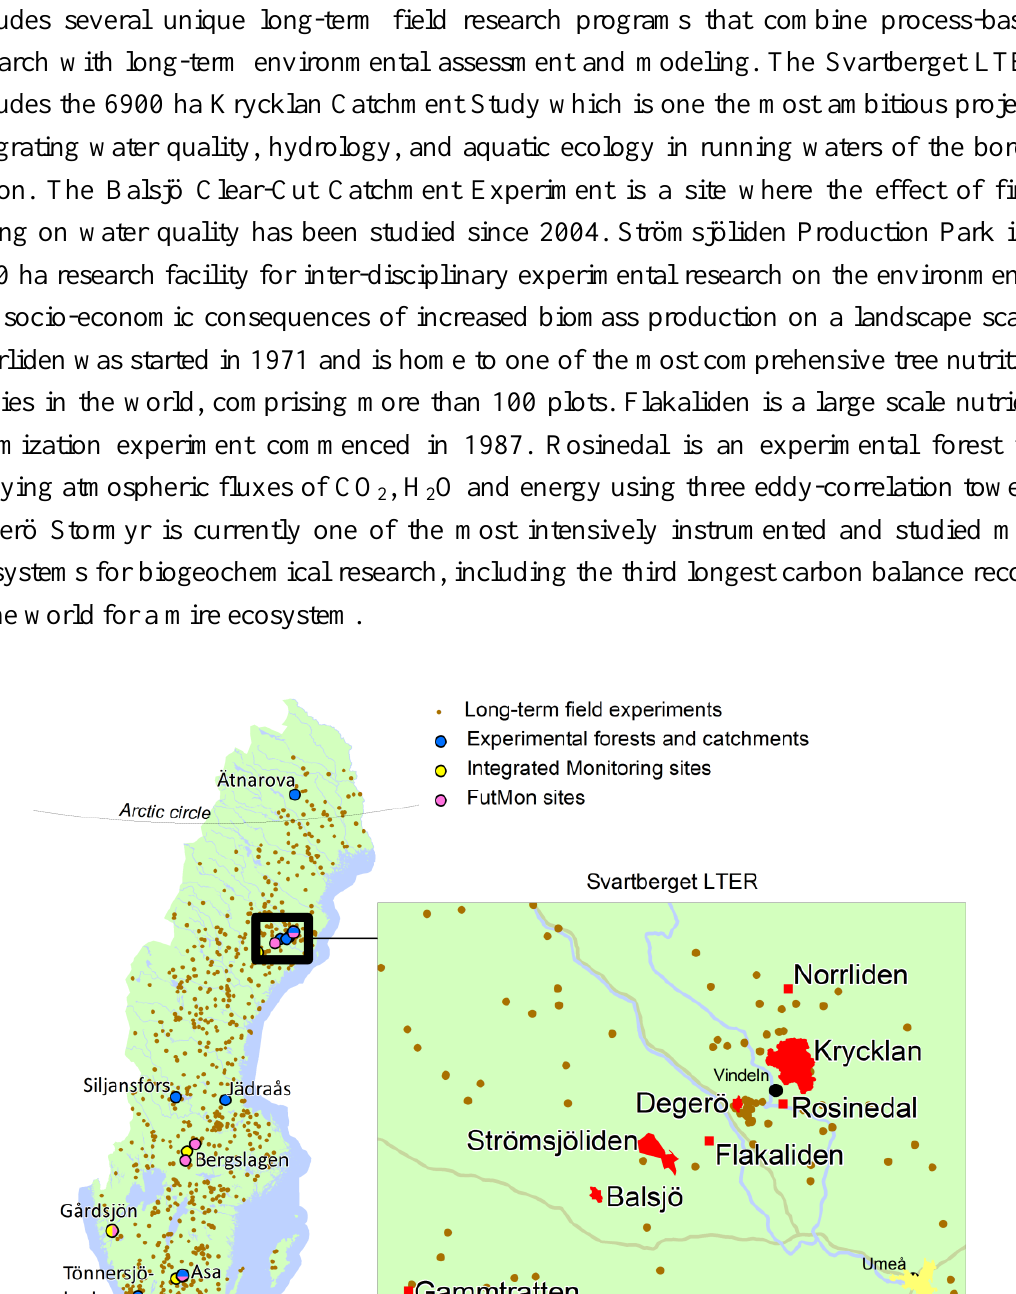
Figure 2. Location of long-term forest experiments in Sweden, as well as sites for integrated monitoring (IM), experimental forests, and forest monitoring (FutMon).